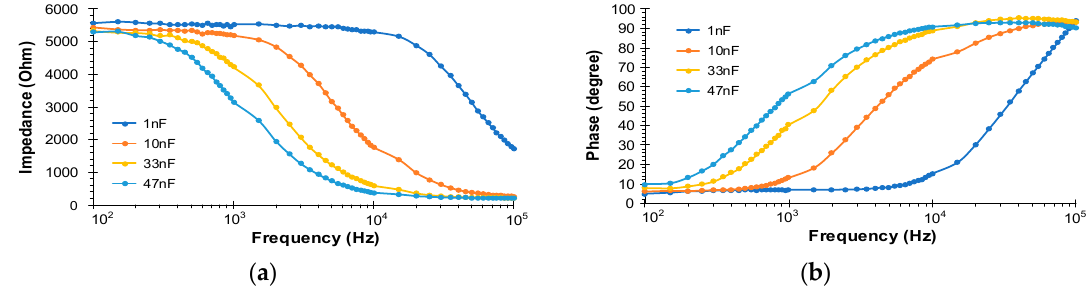
Figure 8. Bode plot of RC experiments: ( a ) impedance magnitude (ohm), and ( b ) phase (degree). Table 1. Measurement result and error calculation Prec. RLC Meter Dev. BIS